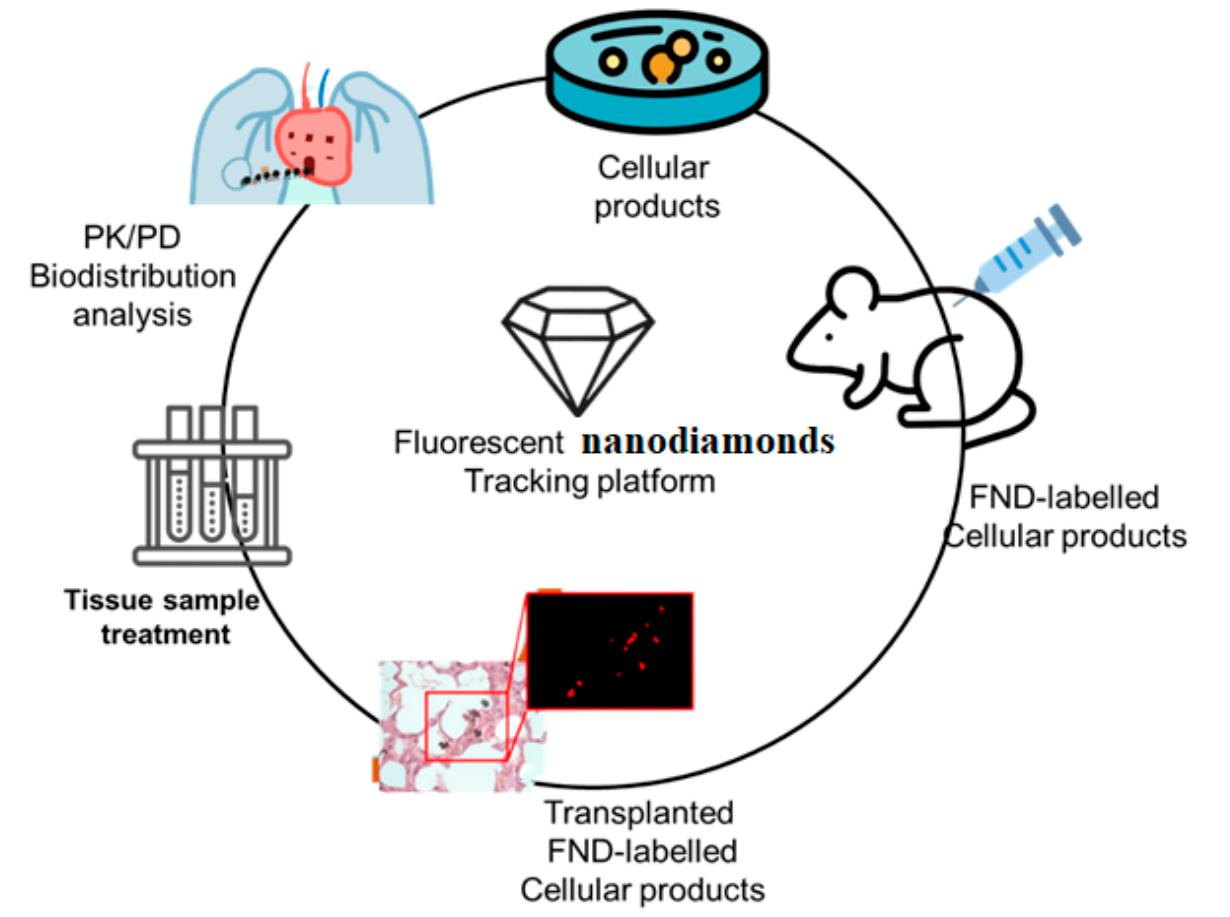
Figure 2. Procedures for the labeling and tracking of pcMSCs with fluorescent nano diamonds (FNDs) and an examination of their bio distribution.